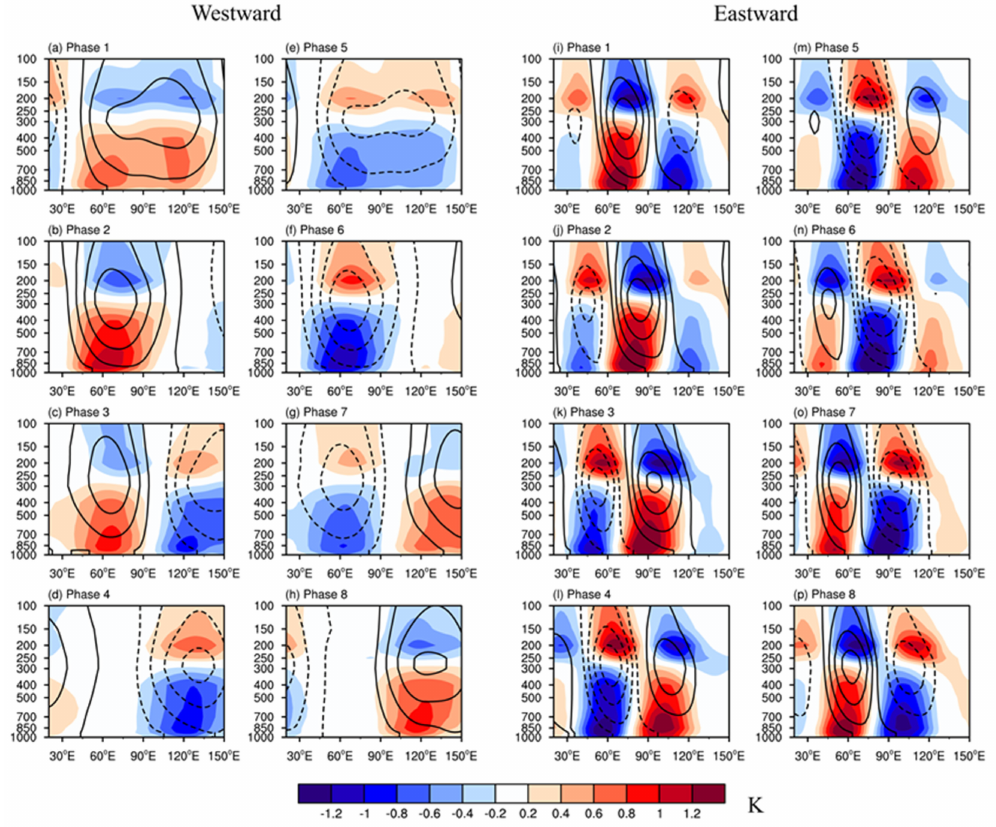
Figure 4. ( a ) The longitude height section of the composite 10–30-day − filtered geopotential height (contour interval: 10 gpm; with zero line omitted) and air temperature (shading; unit: K) anomalies averaged along 40 ◦ –80 ◦ N during the westward-propagating mode. ( b – h ) As in ( a ) but for Phase 2 to Phase 8. ( i − p ) As in ( a − h ) but for the eastward − propagating mode, the anomalies exceeding the 0.05 significance